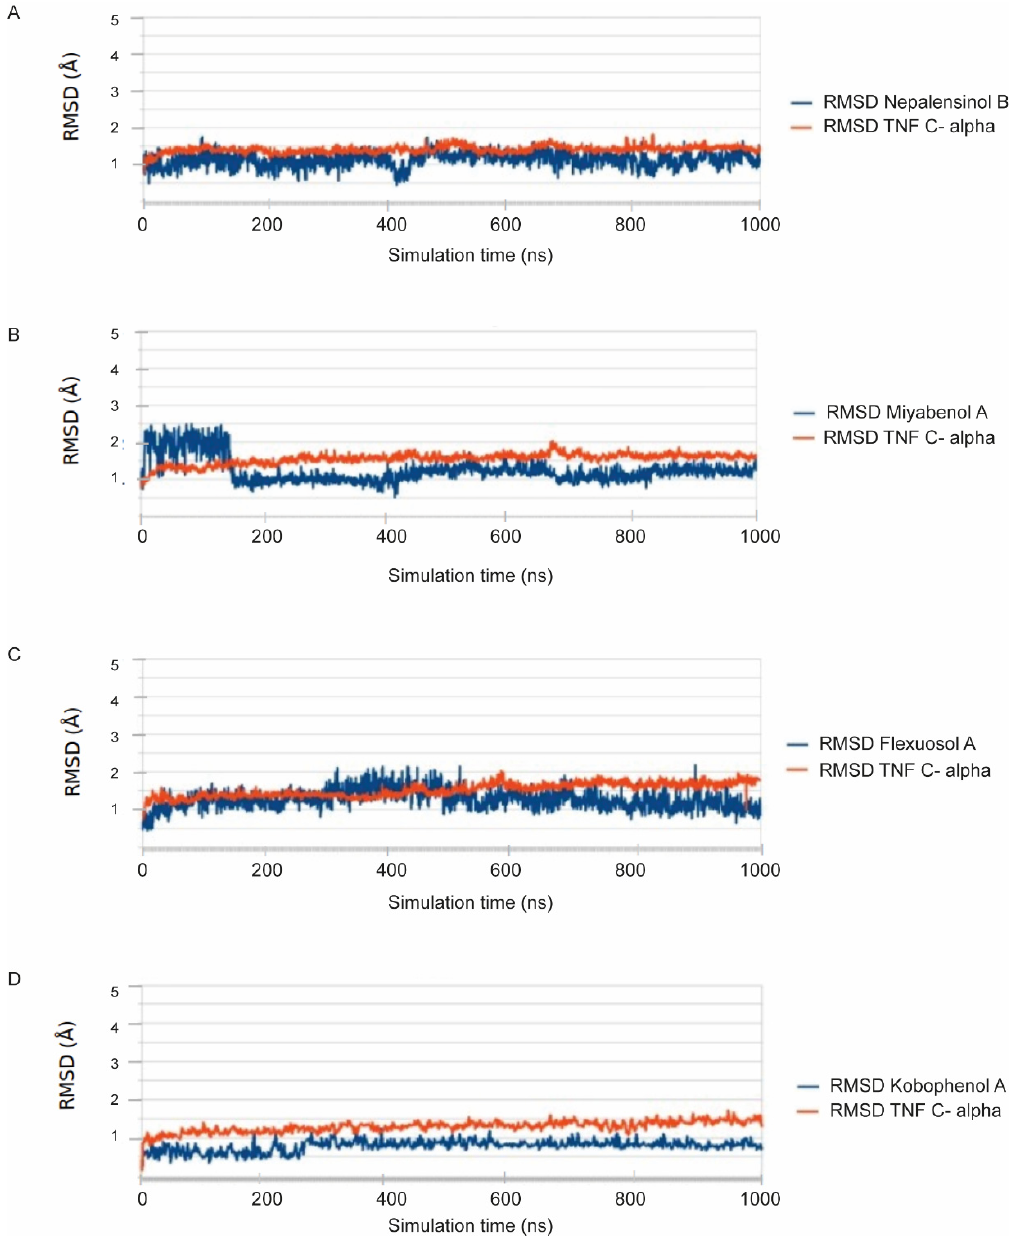
Figure 4. All-atom RMSD calculations. ( A ) Nepalensinol B; ( B ) Miyabenol A; ( C ) Flexuosol A and ( D ) Kobophenol A; in complexes with TNF.